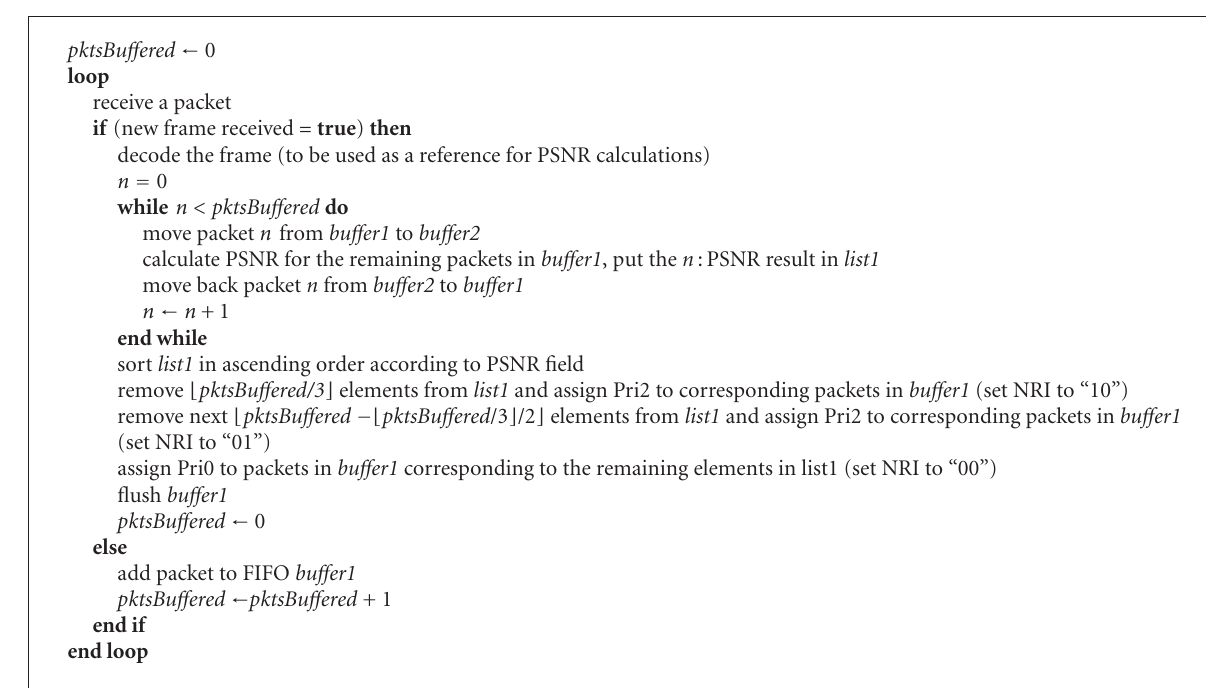
Figure 1: Cyclic intracoded MB line technique for the Paris test sequence, showing successive MB lines in lighter shading, with some slice boundaries also